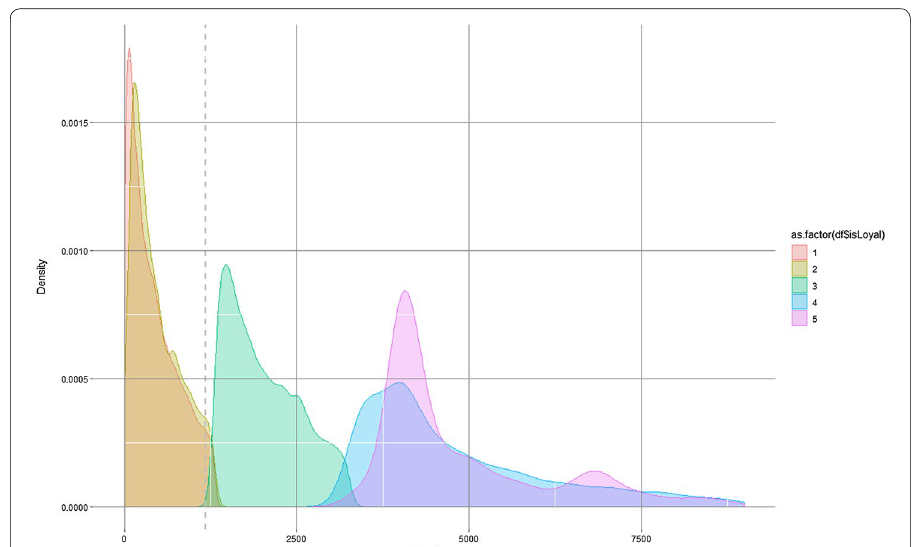
Fig. 4 Mass distribution for M in our Study